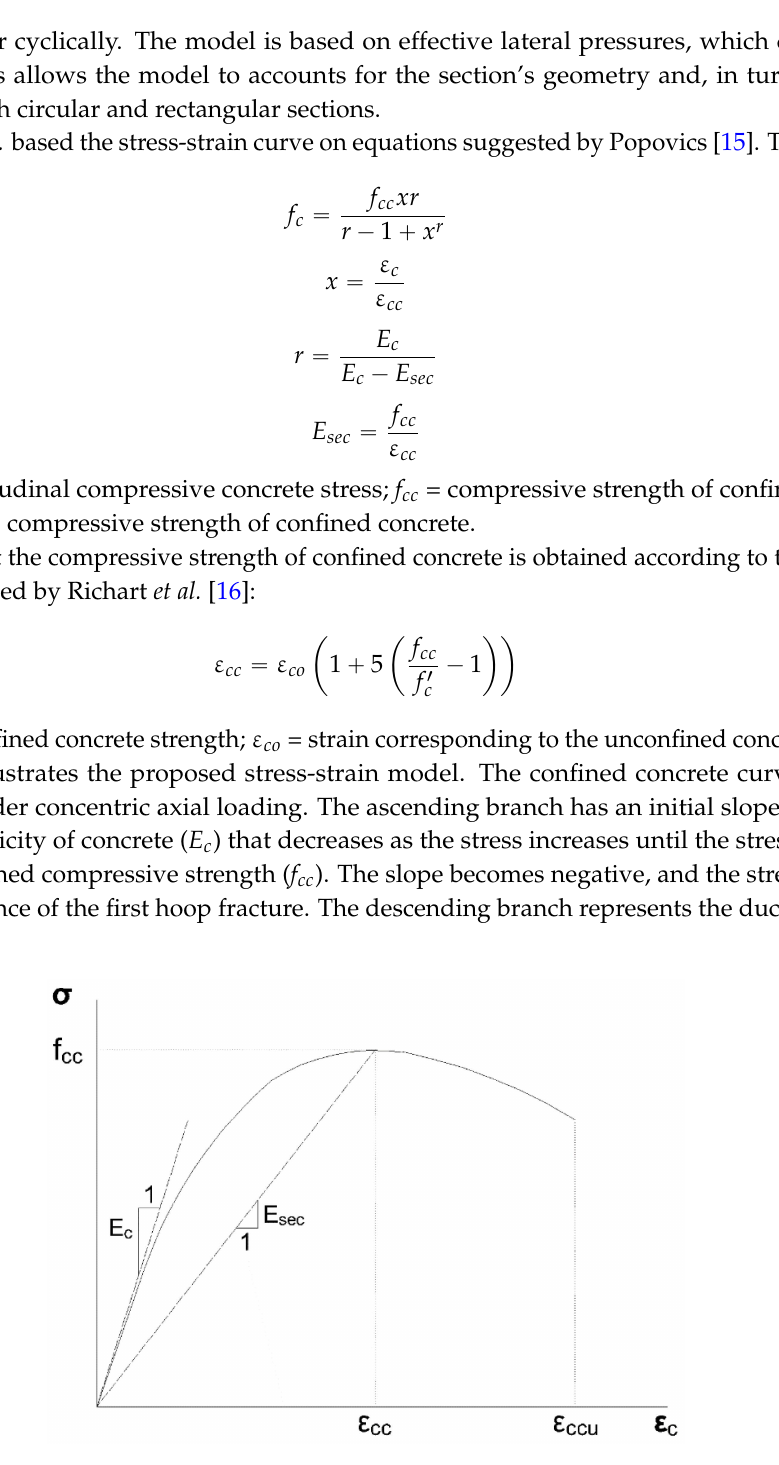
Figure 1. Stress-strain model proposed for concrete confined with steel